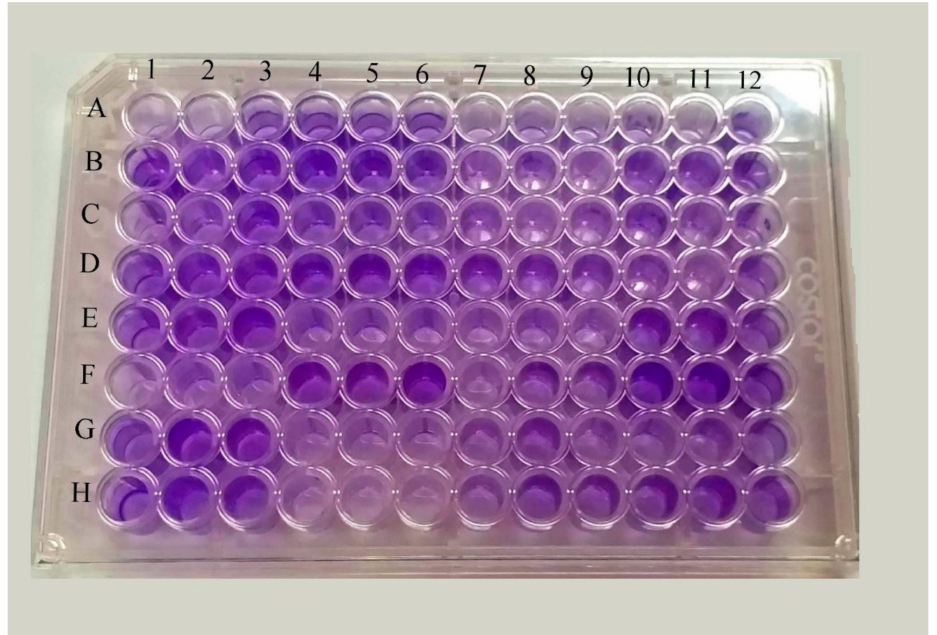
Figure 1. Biofilm production test by the microtiter plate method: negative control (A1, A2, A3), strong producer (F10, F11, F12), moderate producer (B10, B11, B12), weak producer (H7, H8, H9) and non-producer (H4, H5, H6). NB: The higher the ODc, the higher the concentration of the purple color in the presented microtiter well. Concentration of color represents the strength of producing the biofilms from higher to lower as the concentration